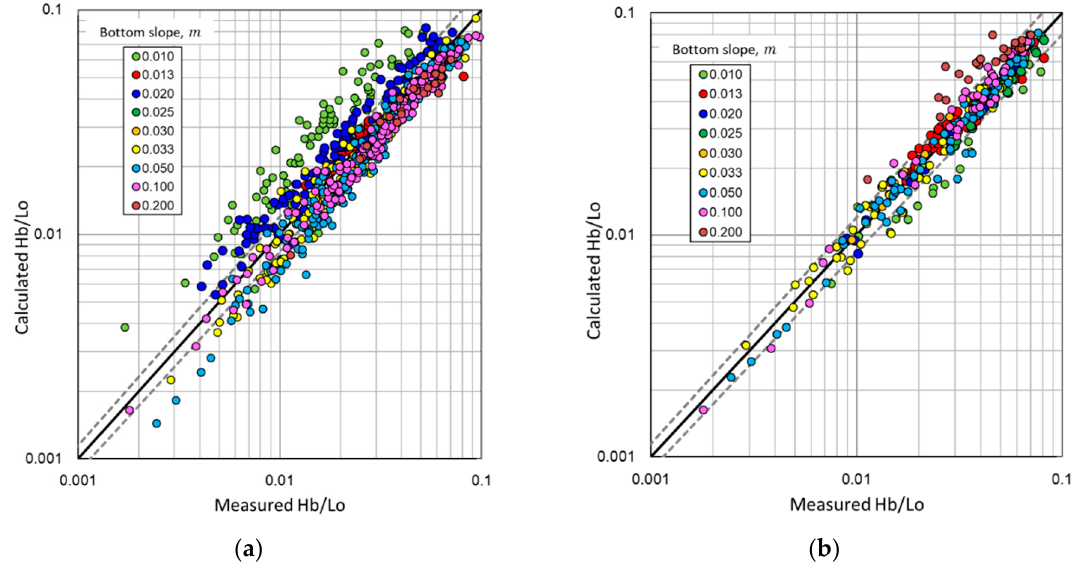
Figure 4. Comparison of wave breaking height formulas with experimental data: ( a ) Rattanapitikon and Shibayama (2006); ( b ) Goda (2010).